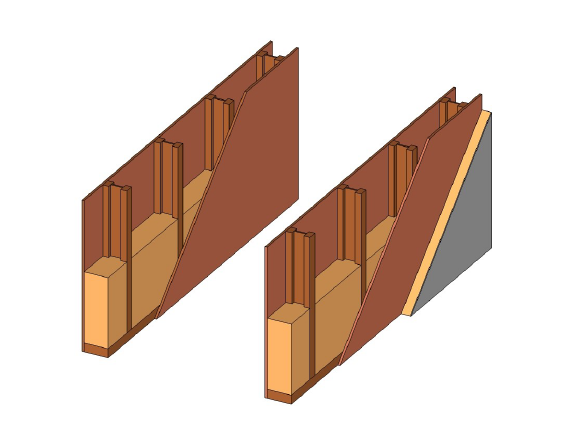
Figure 6. Schemes of tested external walls: basic part of the wall (left), basic part with ETICS (right).